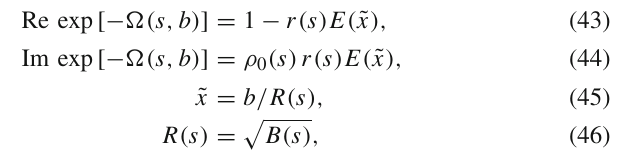
Fig. 1 Scaling behaviour of the differential cross section d σ/ dt of elastic pp collisions in the ISR energy range of The measured differential cross section data are taken from Ref. [63] and references therein. These data are rescaled to H ( x ) = 1 function of x = − tB . This figure indicates a clear, better than expected data-collapsing